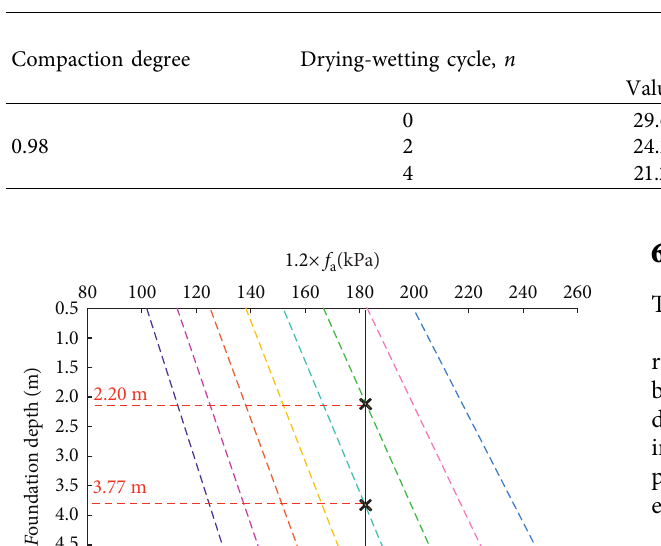
Table 4: Variation of shear strength parameters after vibrations.